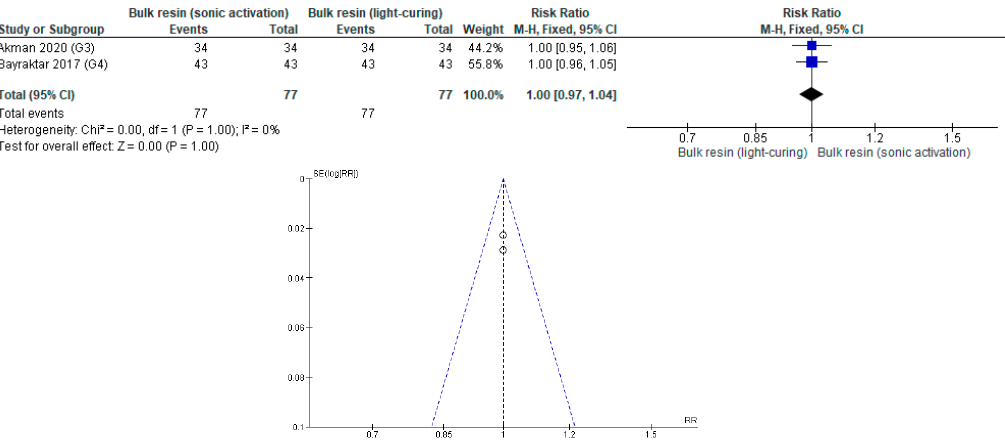
Figure A29. Adequate Color Stability and Translucency: Conventional Resin versus Bulk Resin According to the Technique Used.